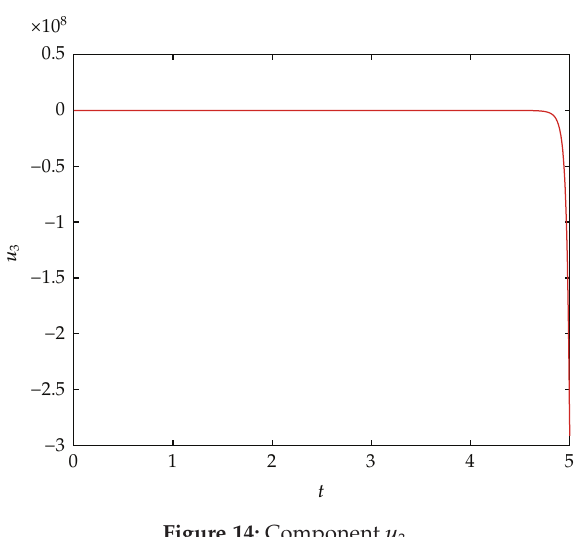
Figure 14: Component u 3